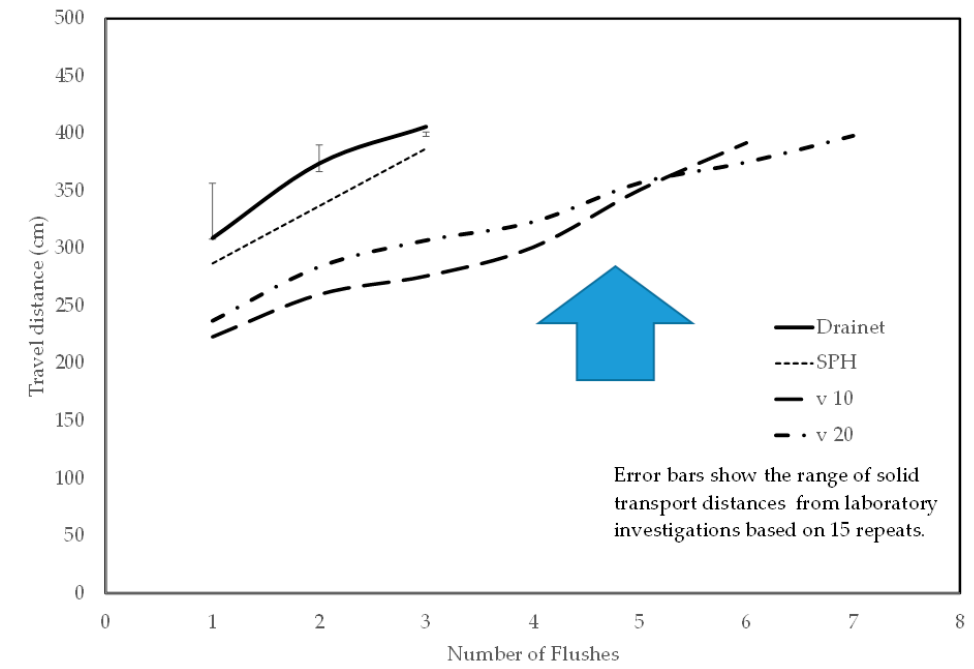
Figure 8. Effect on solid transport of changing the ViscoBoundFactor. Results for three values—1 (SPH), 10 (VBF10), and 20 (VBF20) shown in comparison to DRAINET and results from laboratory investigations for the case where the specific gravity was 0.85.